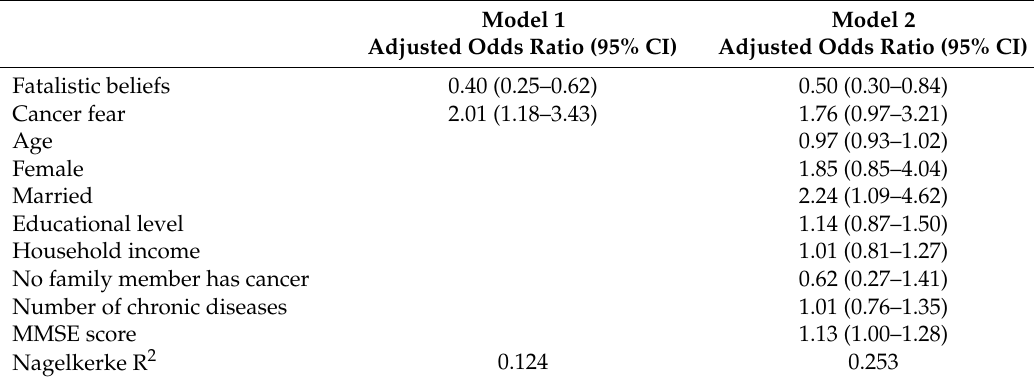
Table 2. Outcome of hierarchical regression analysis of cancer-related information seeking behaviors. MMSE: Mini-Mental State Examination.